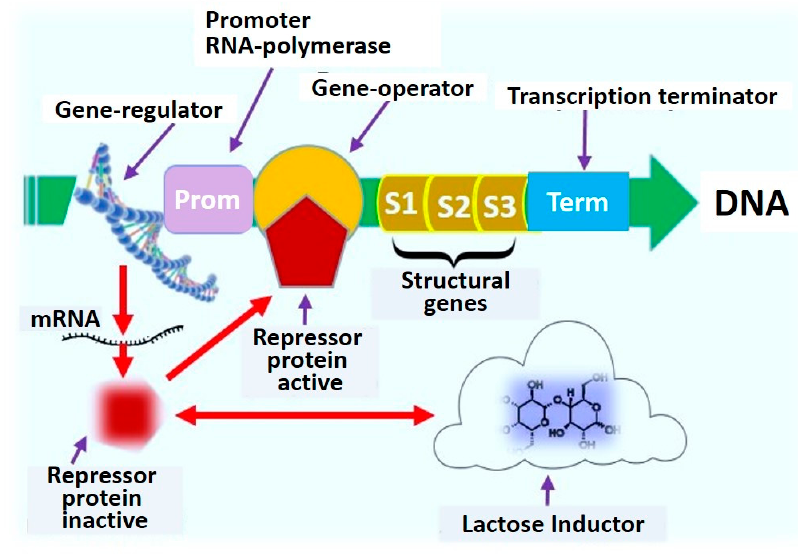
Figure 4. Functional diagram of the lactose lac operon of Escherichia coli in microbial biosensors.